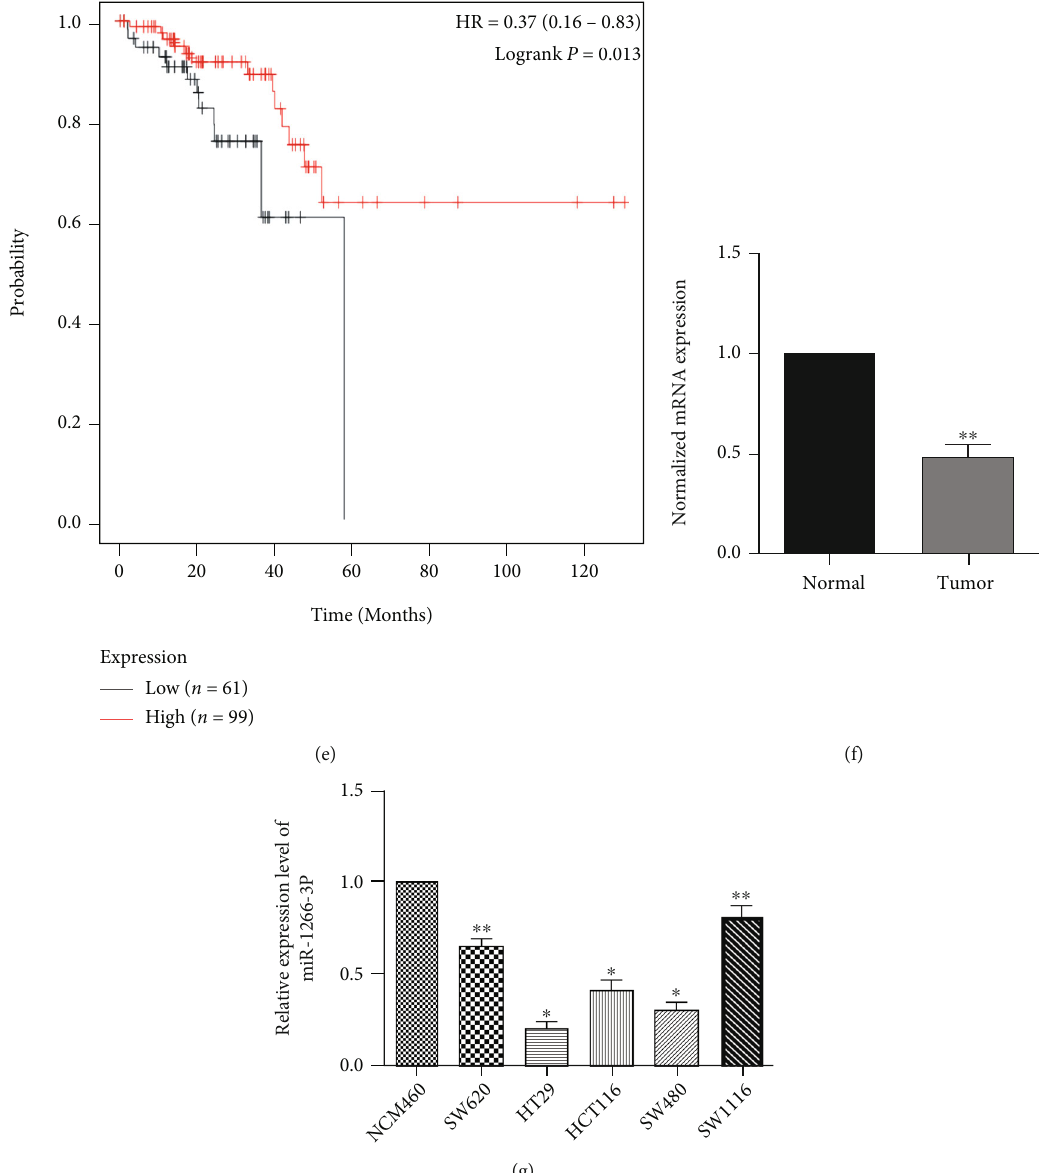
Figure 1: MiR-1266-3p expression in colon carcinoma cells and tissues. (a) MiR-1266-3p expression in the GSE35834 dataset of the GEO database ð ∗∗ P < 0 : 01 Þ . (b) MiR-1266-3p expression in TCGA-COAD database ð ∗∗∗ P < 0 : 001 Þ . (c) MiR-1266-3p expression in di ff erent stages of colon cancer ( ∗∗∗ P < 0 : 001 ). (d) MiR-1266-3p expression in the di ff erent lymph node metastasis states in colon cancer ( ∗∗∗ P < 0 : 001 ). (e) Kaplan-Meier survival curve comparison of miR-1266-3p di ff erential expression in colon cancer. (f) MiR-1266-3p expression in fi ve pairs of colonic carcinoma tissues and para-cancerous tissues ( ∗∗ P < 0 : 01 ). (g) MiR-1266-3p expression in six types of cell lines ( ∗ P < 0 : 05 ∗∗ P < 0 : 01